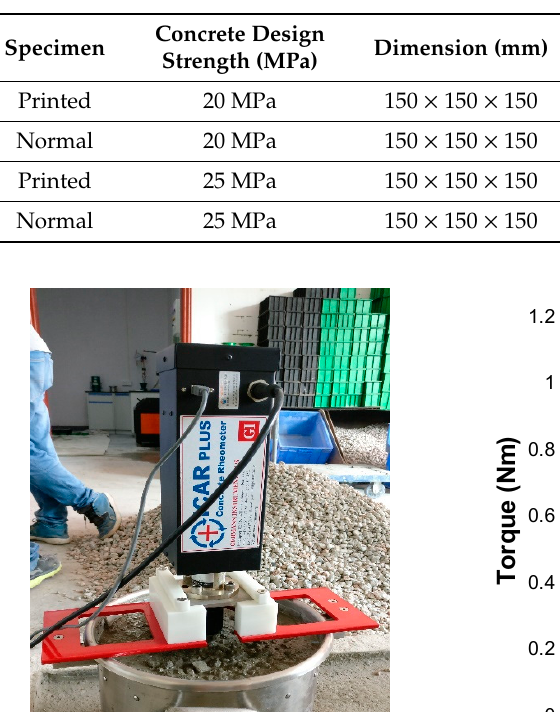
Table 2. Comparison of concrete compressive strength tests.